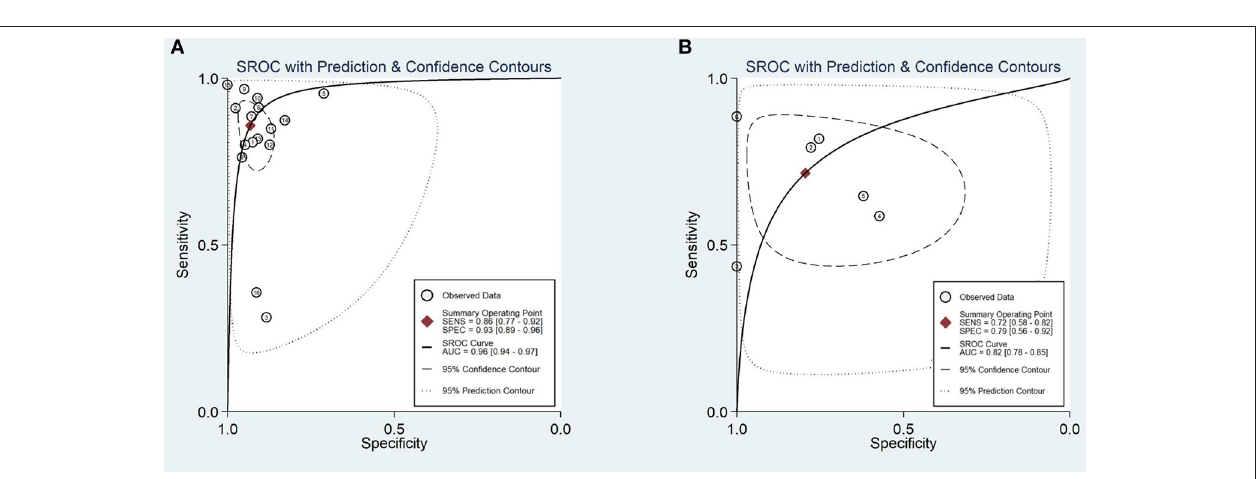
FIGURE 4 | Area under the receiver operating characteristic curve (A) . The AUC of the AI-assisted endoscopy diagnose in the EGC detection was 0.96 (95% CI, 0.94–0.97). (B) The AUC of the AI-assisted endoscopy diagnose in the EGC depth distinction was 0.82 (95% CI,